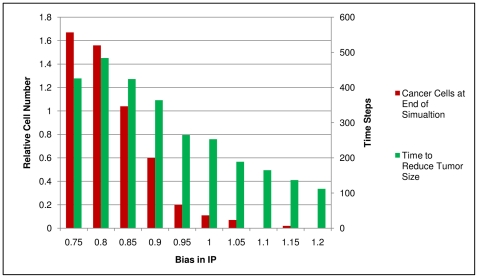
Error Propagation from IP to Simulation.The relative number of cancer cells after one year of treatment compared to the tumor size at the beginning of the simulation is depicted (red bars) along with the average number of time steps needed to reduce the tumor size (green bars). All interaction probabilities in the simulation calculated with IP were multiplied with the bias in IP shown on the y-axis. Data were obtained from 100 simulations per column. The MHC-genotype is HLA_A02/HLA_DRB1-1. For all experiments one hundred initial cancer cells were simulated within 5 µl of blood that were treated with peptide injections starting at time point zero and being repeated five times at an interval of 28 days. The antigen B7Z8B0_HUMAN was chosen from over-expression data in prostate tumors. One MHC I-binding peptide and one MHC II-binding peptide were injected.